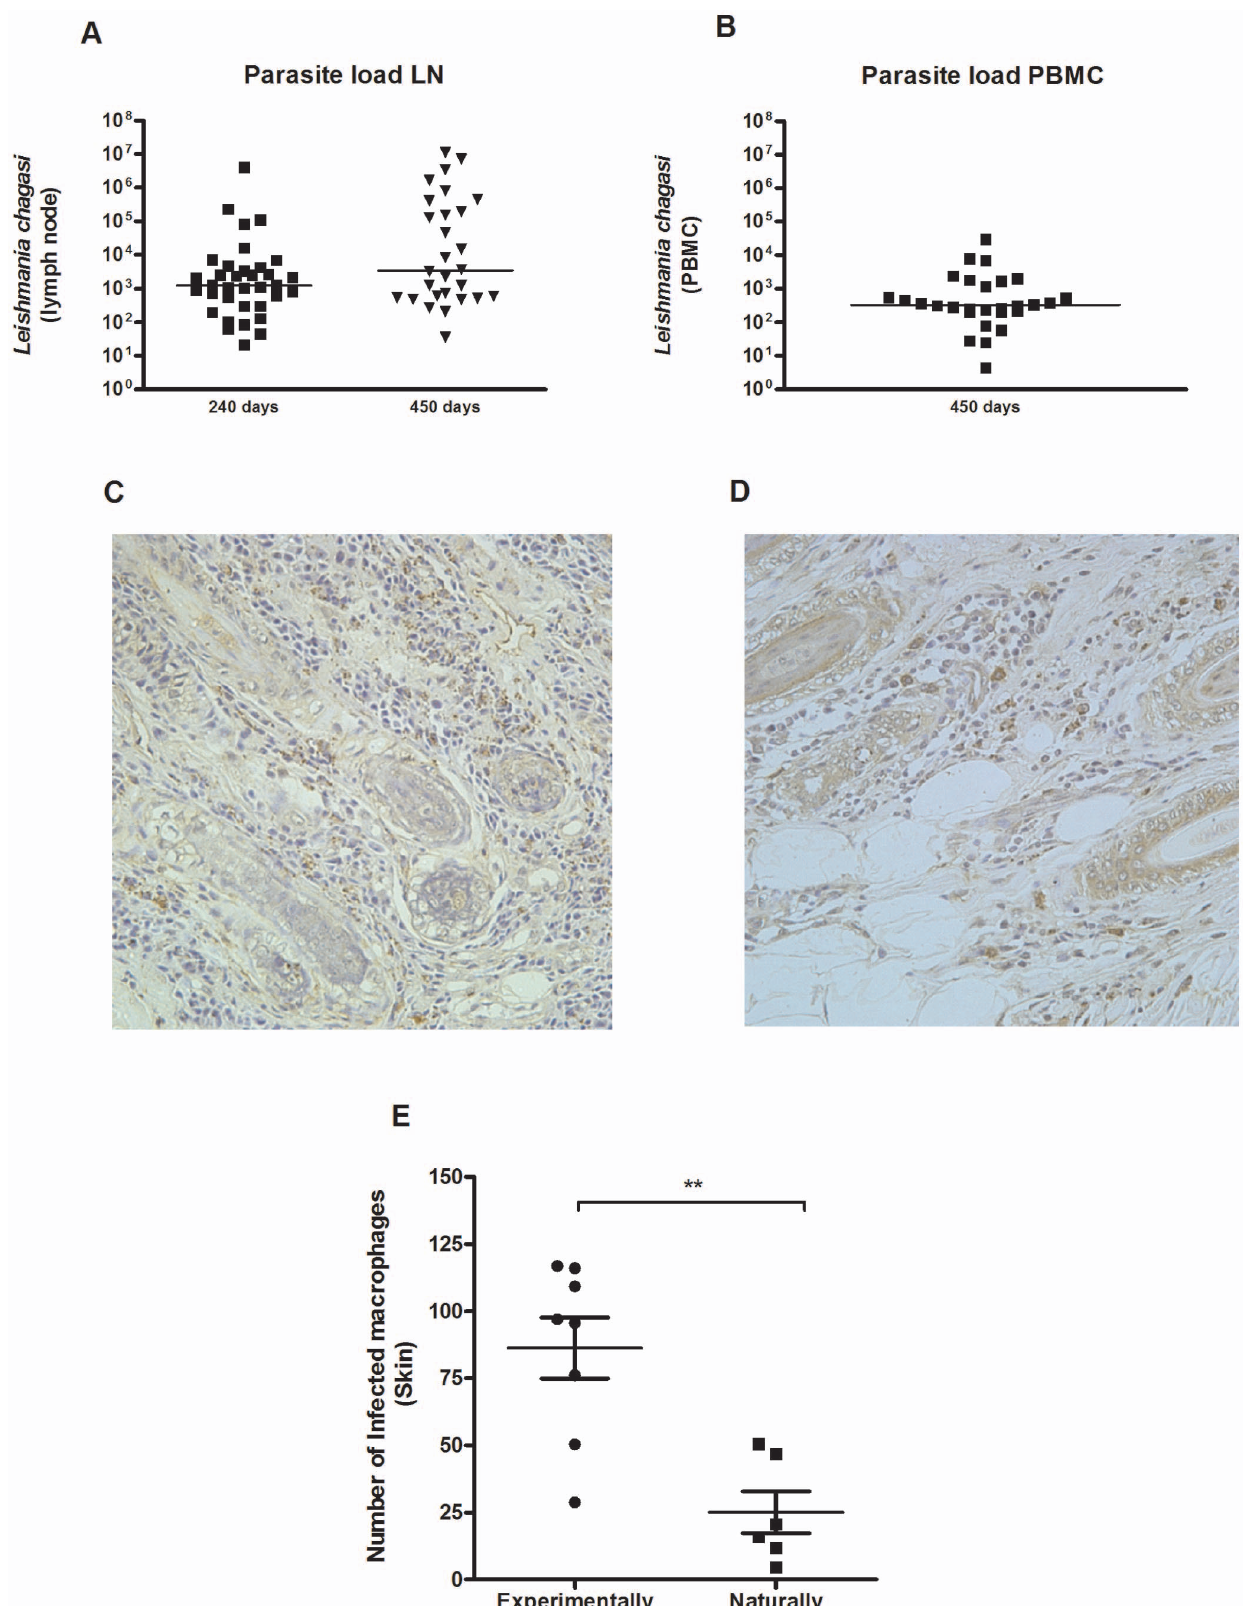
Figure 2. Parasitological parameters in experimentally and naturally infected dogs. Parasite load in dogs experimentally infected with 10 7 promastigotes of Leishmania infantum-chagasi plus five pair of Lutzomyia longipalpis salivary glands through intradermal route. Total DNA was